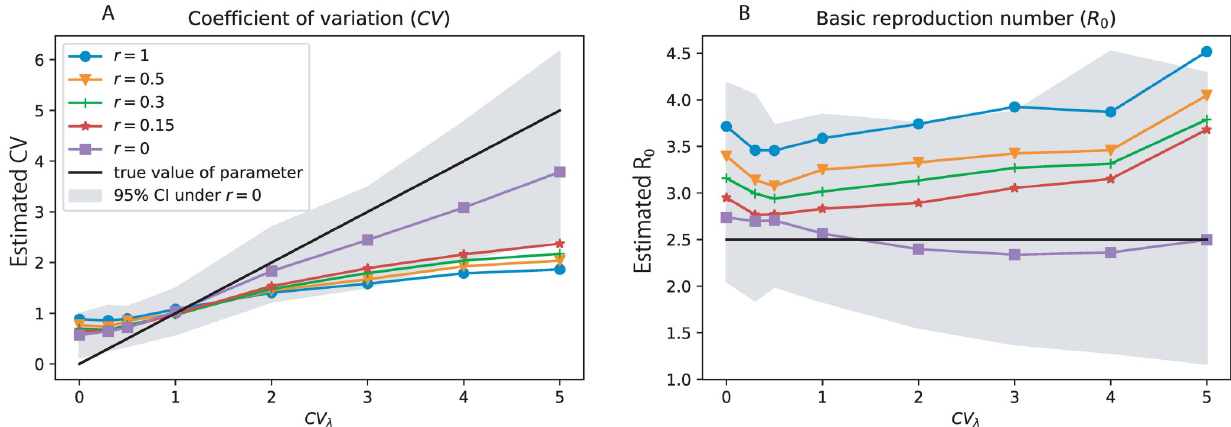
Fig 5. Performance of parameter estimation in the presence of within-host diversity. Here r denotes the rate of within-host population size increases (per day). Four levels of within-host diversity have been calculated: r = 1(blue), 0.5(orange), 0.3(green), 0.15(red), and r = 0 (purple) corresponding to no heterogeneity. Results are the mean of 100 simulations. Also the estimates (purple) and the corresponding 95% confidence intervals (shaded area) under the condition without within-host diversity are also calculate for comparison.